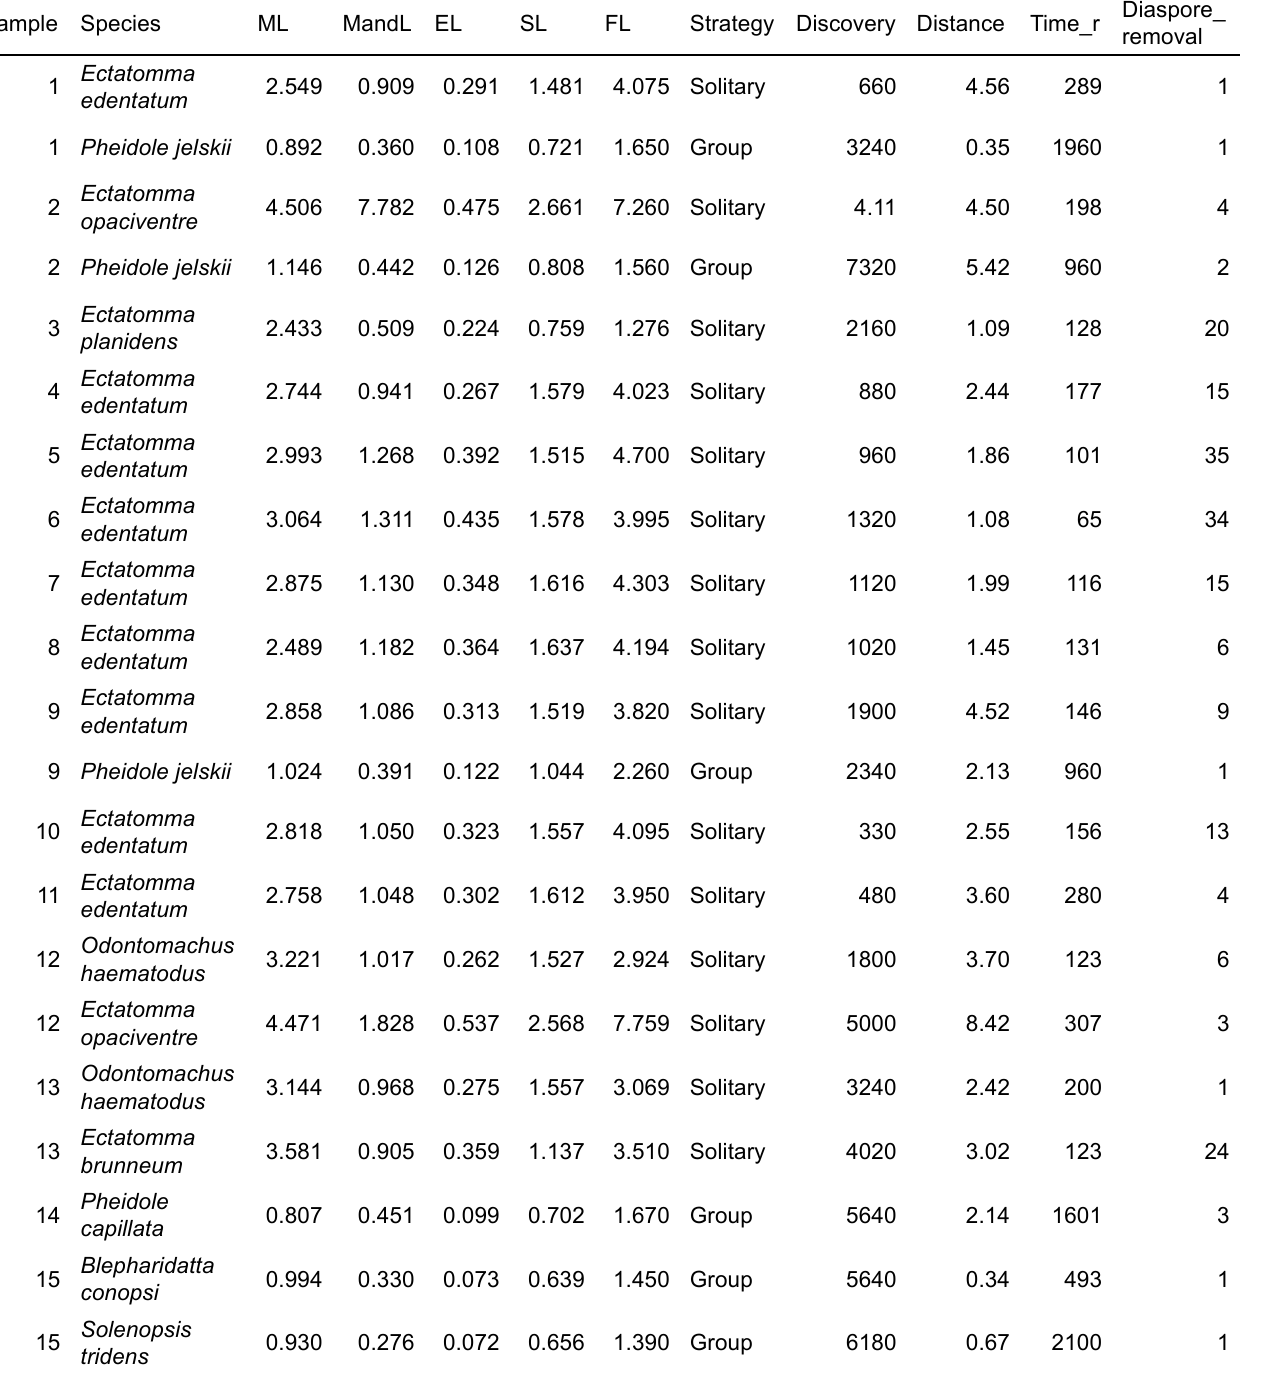
Table S1 . Sampling areas, species sampled, and variables collected: sample (sampled areas - 1 to 15); specie (ants species - Hymenoptera: Formicidae); ML (Mesosomal or Weber’s length - millimeters - mm); MandL (Mandible length - millimeters - mm); EL (Eye length - millimeters - mm); SL (Scape length - millimeters - mm); FL (Leg length - summing the femur and tibia length of posterior metathorax leg - millimeters - mm); strategy (foraging strategy - solitary or group); discovery (discovery time of diaspores - seconds - s); time_r (removal time of diaspores - seconds - s); diaspore_removal (artificial diaspores removal by ants - Hymenoptera: